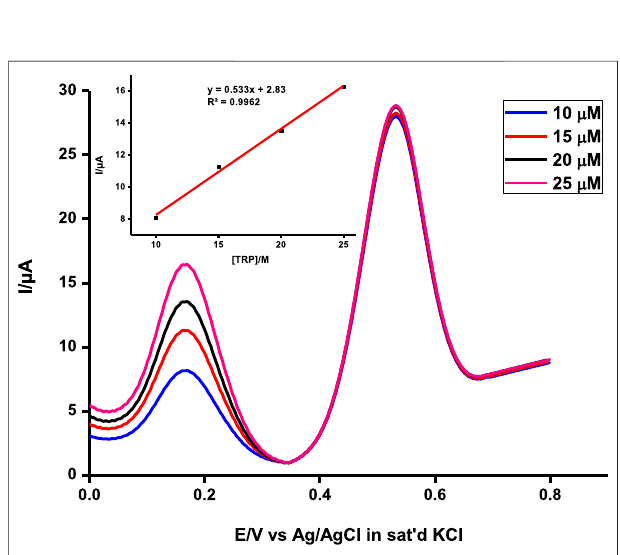
FIGURE 8 | Simultaneous detection of a range of concentrations of ascorbic acid at a constant tryptophan concentration at pH 5 on poly- CoTCPc-CoTAPc-GONS/GCE. Scan rate, 100 mV/s.